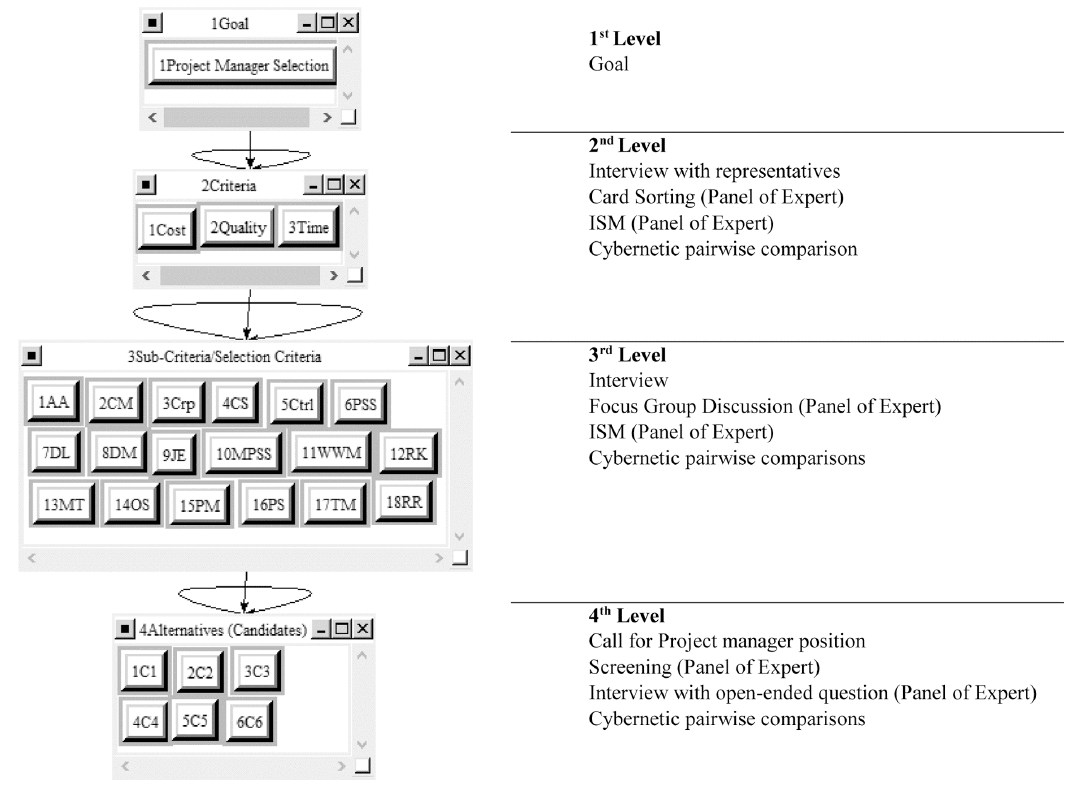
Fig. 3. ANP decision network of project manager selection